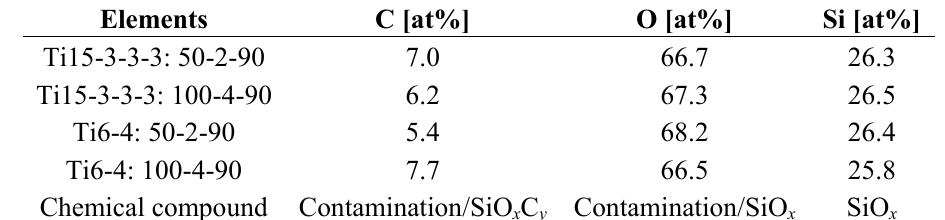
Table 2. Chemical composition of the titanium surface after atmospheric plasma deposition (sample nomenclature: Ti15-3-3-3 = Ti 15 V 3 Cr 3 Sn 3 Al, Ti6-4 = Ti 6 Al 4 V, 50